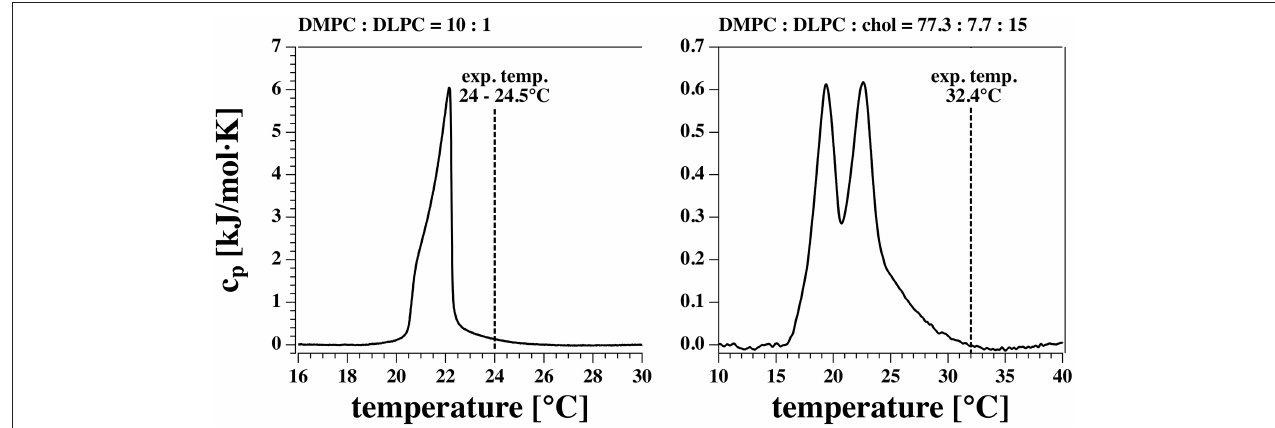
FIGURE 1 | Calorimetric profiles of the two lipid mixtures used. The vertical dashed line indicates the experimental temperature at which I-V profiles and currents were measured.